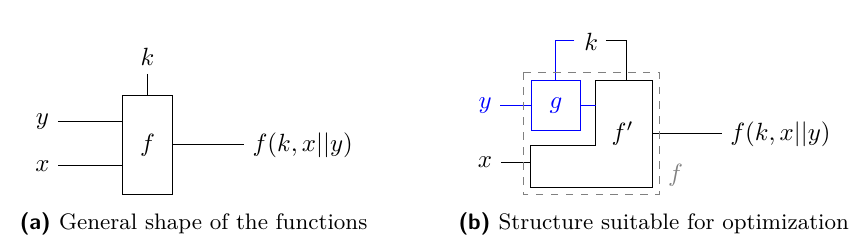
Figure 8: Functions we use in Simon’s